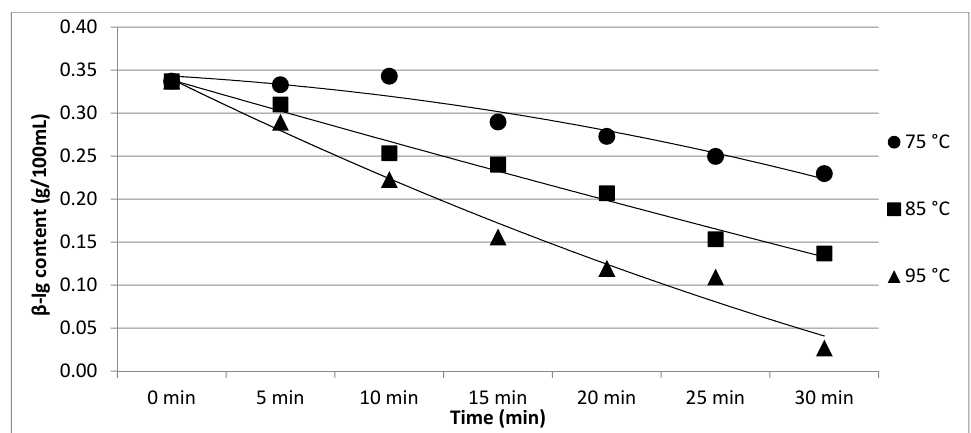
Figure 9. Effect of heating temperature and time on β -lg content. Equations: 75 °C (y = − 0.0021x 2 − 0.0035x + 0.3488; R 2 = 0.933), 85 °C (y = 0.0003x 2 − 0.037x + 0.3753; R 2 = 0.9842), 95 °C (y = 0.002x 2 − 0.0658x + 0.4034; R 2 = 0.9802).